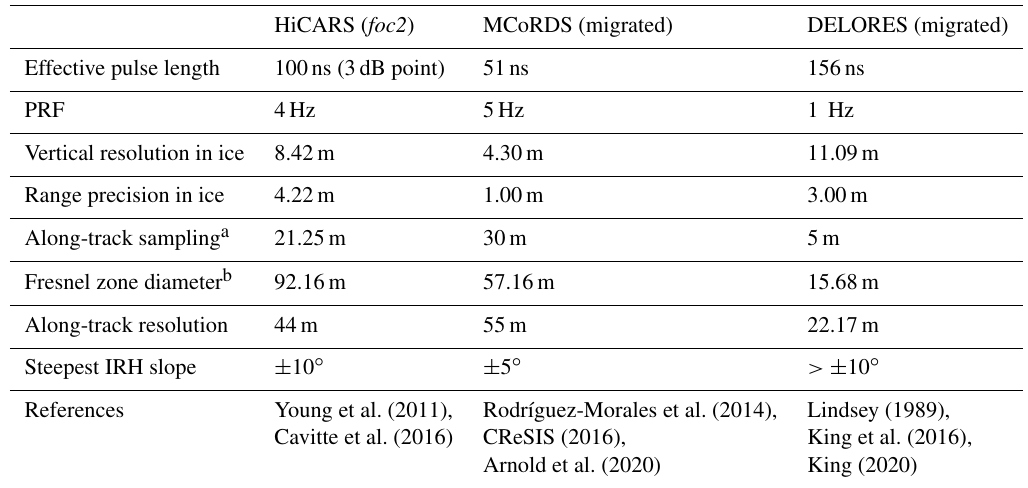
Table 2. Ice-penetrating radar post-processed data characteristics. Range precision is provided for an IRH with 6dB SNR; Fresnel zone diameter and along-track resolution (after focusing and multilooking) are calculated at 1000m depth in ice and an altitude of 500m above the ice in the case of HiCARS and